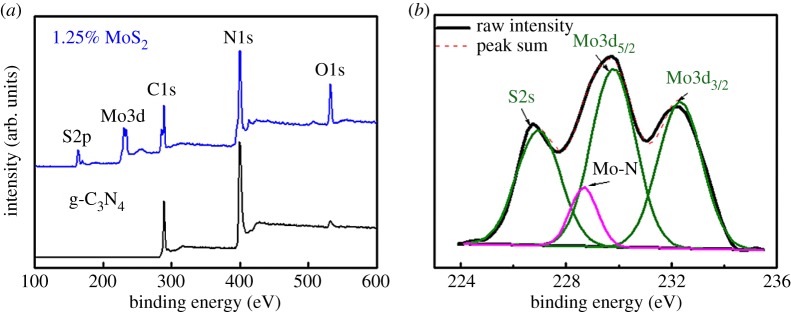
XPS spectra of: (a) a survey spectrum of pristine g-C3N4 and a sample of 1.25% MoS2. (b) High resolution of peak Mo3d from the sample of 1.25% MoS2.